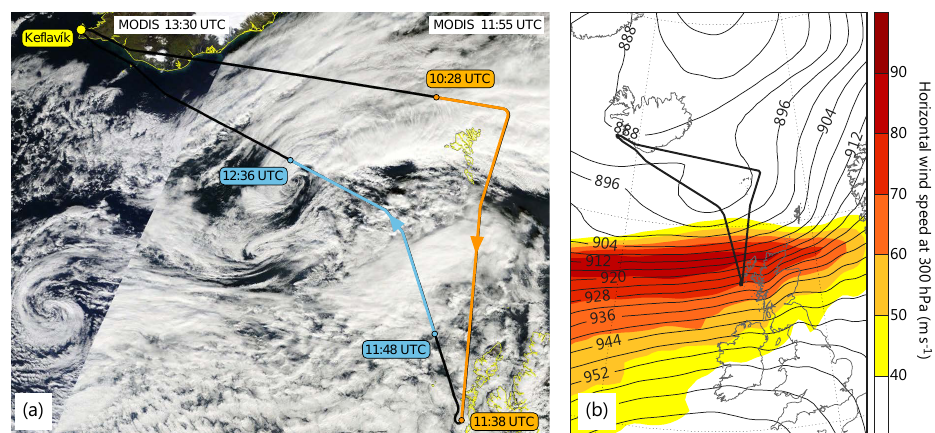
Figure 5. (a) Flight track of the Falcon aircraft (black line) during the research flight conducted on 27 September 2016. The wind scenes performed from 10:28 to 11:38 and from 11:48 to 12:36UTC are indicated in orange and blue. The background picture is composed of a map provided by Google Earth and satellite images from Terra MODIS (VIS channel) taken at 11:55 (right part) and 13:30UTC (left part) (MODIS, 2017a). (b) Geopotential height (black isolines, in dekametres) and horizontal wind speed (colour shading) at 300hPa on 27 September 2016, 12:00UTC, from ECMWF model analysis together with the flight track of the Falcon 20